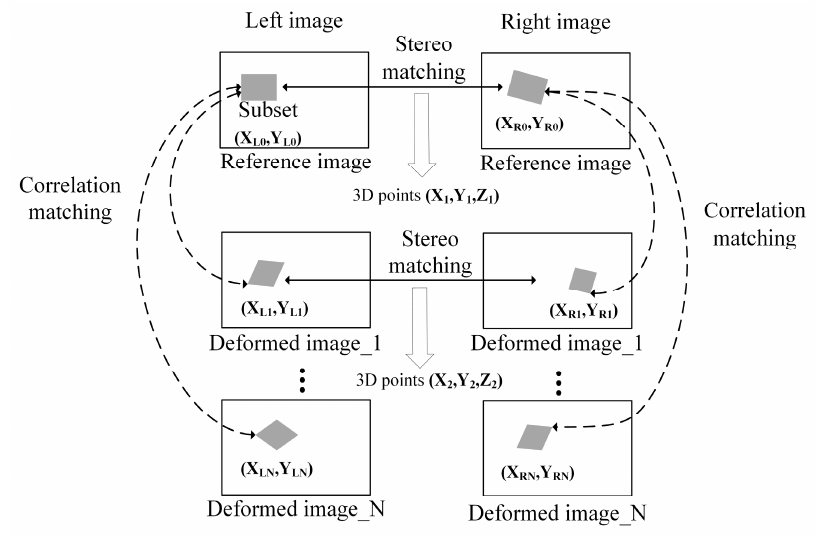
Figure 3. Iteration process of IC-GN method.